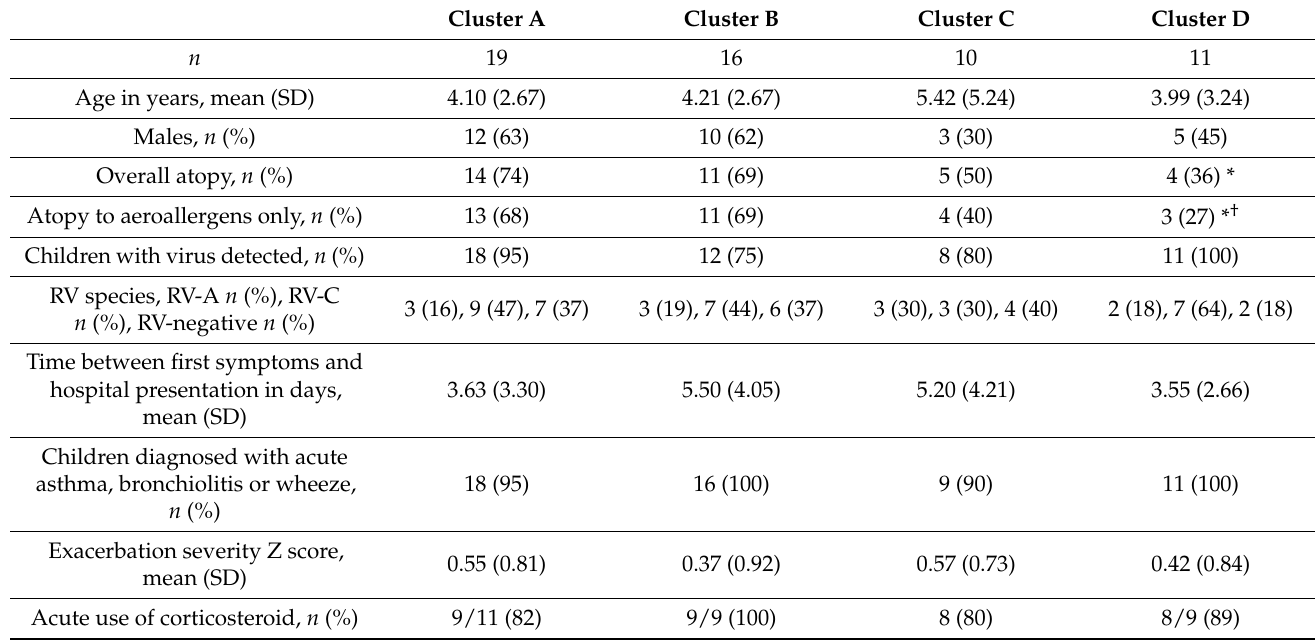
Table 2. Clinical characteristics of Clusters A, B, C, and